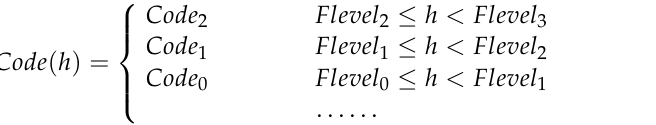
Figure 5. Planar dimensional coding scale and bit representation.